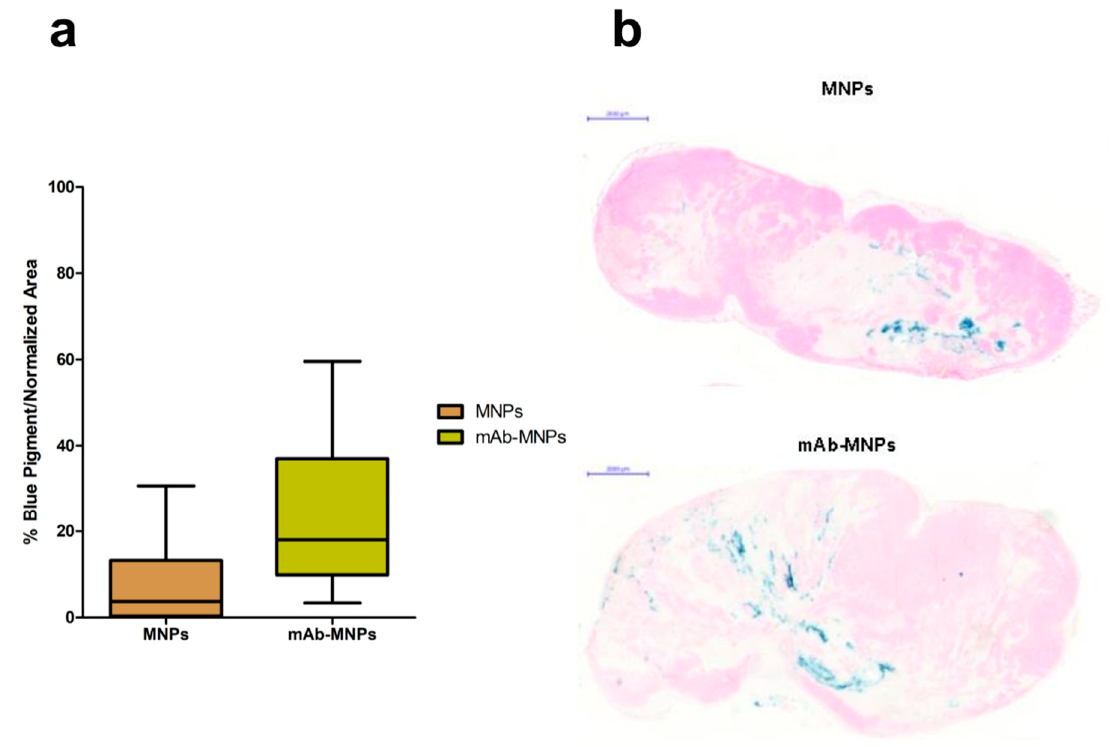
Figure 12. Distribution of mAb-targeted and not targeted MNPs in Met oncogene positive (Met / HGFR + ) GTL-16 cells induced tumors. NOD / SCID- γ null mice bearing GTL-16 cells induced tumors were injected intratumorally with MNPs functionalized or not with the DO-24 mAb and killed after 3 days. Tumors were recovered and processed for staining with Prussian blue. Box and whisker plots summarize the results obtained from measuring the distribution and quantification of MNPs in the tumors ( a ). The % of Prussian blue staining and standard area from 5 randomly chosen areas from each of the 3 tumor sections (100 microns apart) for each of the 7 tumors (n = 105) was determined. Each plot shows the minimum, first quartile, median, third quartile, and maximum values of these % for tumors treated with MNPs and mAb-MNPs. Statistical analyses showed significant di ff erences between the treatments, with a p < 0.0001 and p < 0.0008 for t and F tests, respectively. Representative tumor sections from mice receiving not functionalized or mAb- functionalized MNPs ( b ).